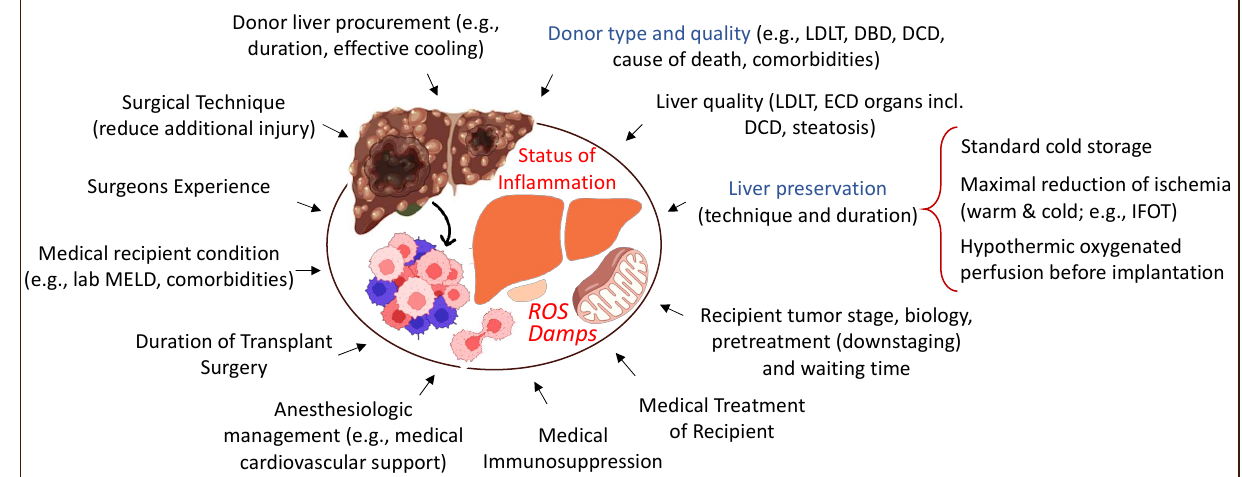
Figure 2 . Overview of tributary factors to tumor recurrence in the context of liver transplantation. Various surgical and medical elements contribute to a higher local and systemic inflammation with frequent tumor recurrence. LDLT: living-donor liver transplantation; DBD: donation after brain death; DCD: donation after circulatory death; ECD: extended criteria donor; MELD: model of end-stage liver disease; IFOT: ischemia-free organ transplantation. This figure was designed with the support from biorender.com (accessed on 15 June 2022).